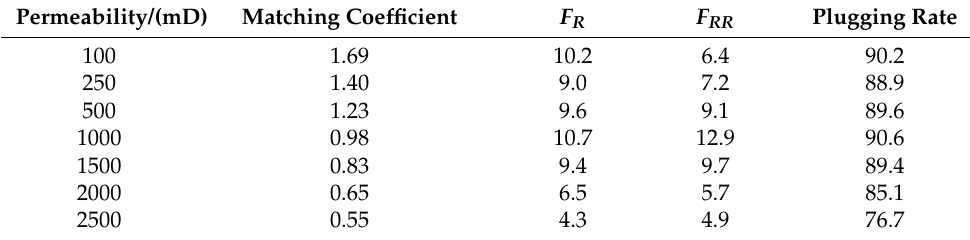
Figure 6. The experiment results of matching between SMG- μ m and reservoir. Table 2. The matching results between SMG- µ m and reservoir.